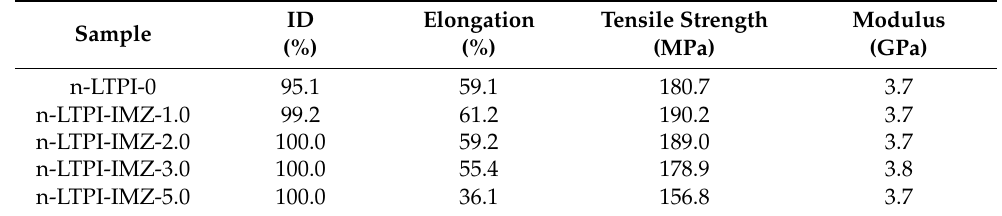
Table 3. Mechanical properties of the thermally cured n-LTPI films at 230 ◦ C/2 h with different loadings of heteroaromatic